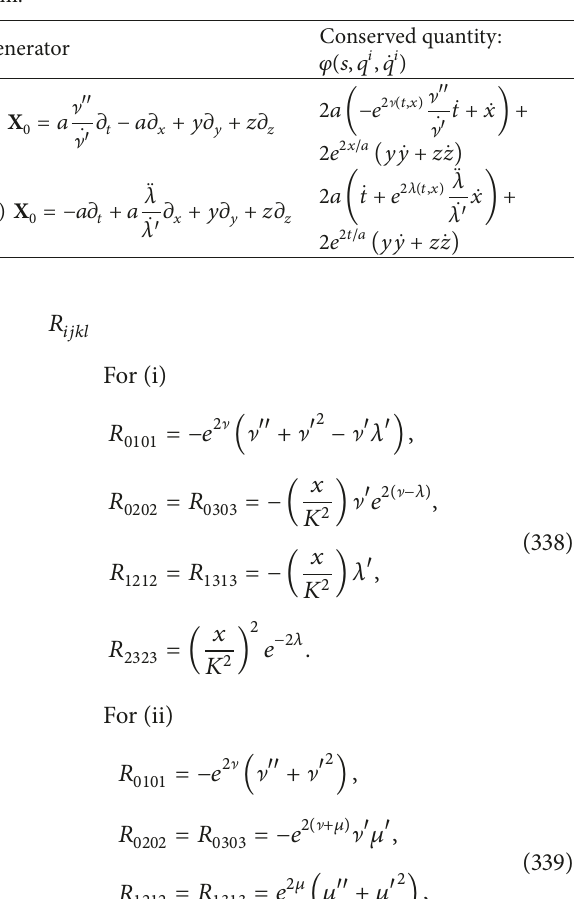
Table 44: Conserved quantity corresponding to the Noether sym- metry.